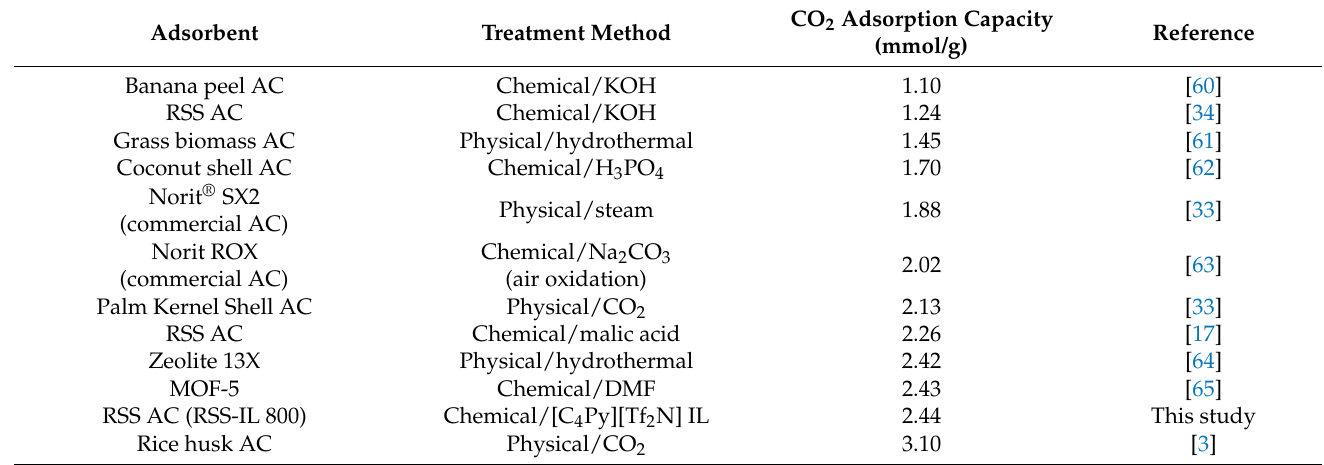
Table 5. CO 2 adsorption capacity with different biomass materials at 25 ◦ C and 1